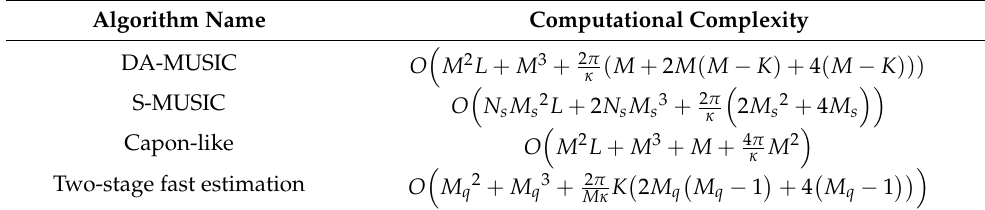
Table 1. Computational complexity analysis for four